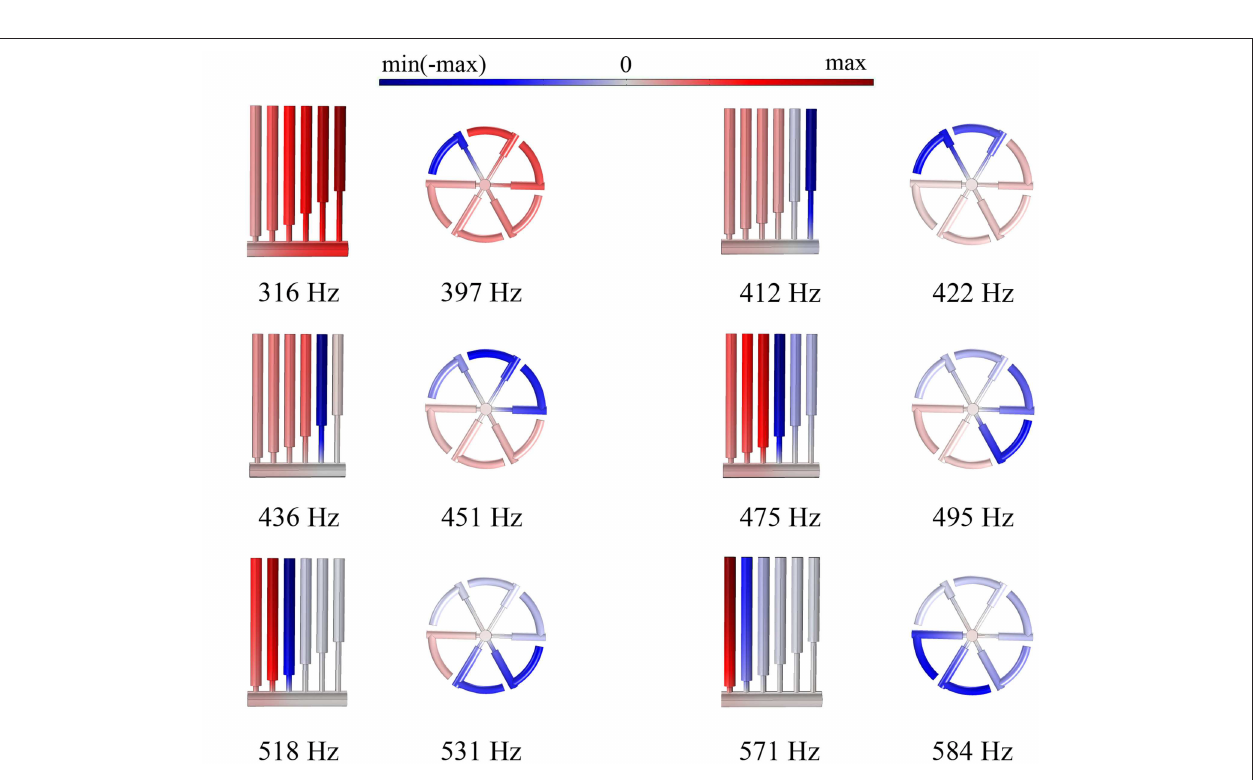
Frontiers in Materials |